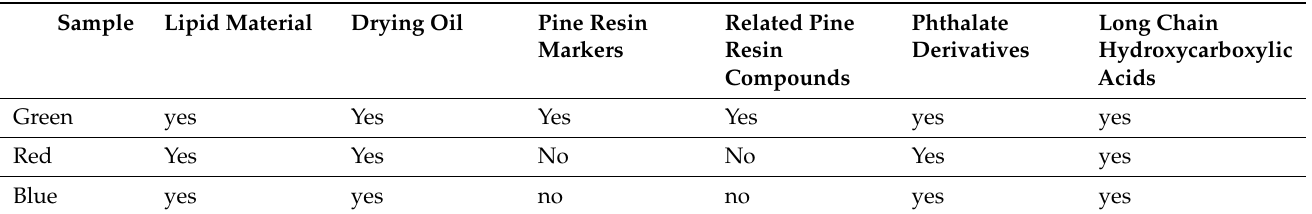
Table 3. Summary of the main compounds and materials identified in the chromatograms of the lipid-resinous fraction of the